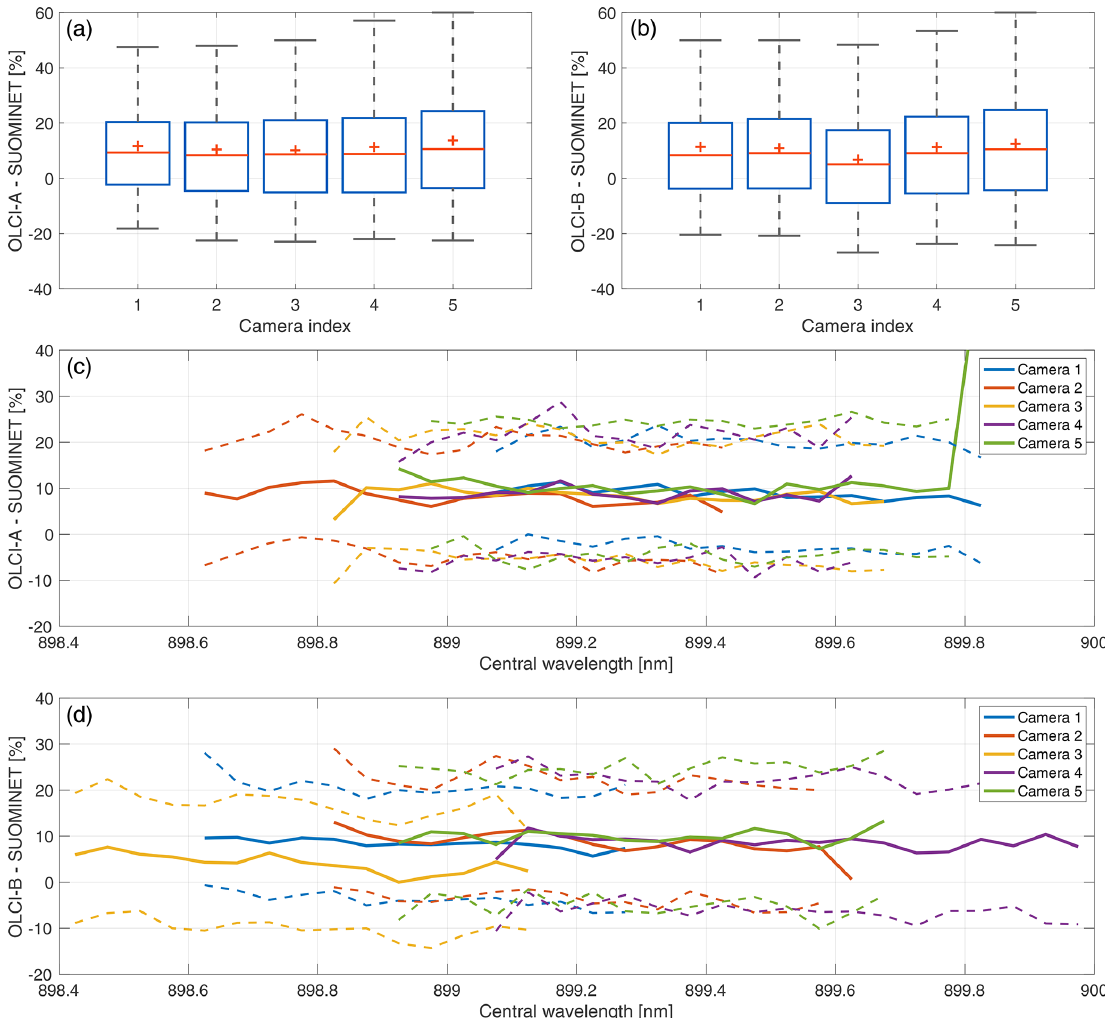
Figure 6. Dependency of OLCI–SuomiNet relative difference on camera index. (a, b) Distributions of relative differences for OLCI-A (a) and OLCI-B (b) matchups with SuomiNet observations for OLCI cameras 1–5. Red lines show the medians of the distributions and blue boxes the 16th and 84th percentiles of the distribution with black whiskers showing percentiles 2.5 and 97.5. Red crosses show the means of the distributions. (c, d) Relative difference as a function of central wavelength of the detector for OLCI-A (c) and OLCI-B (d) . Colours represent cameras 1–5 (see legend), and the solid and dashed lines represent the median and the interpercentile range (16th–84th) percentiles,